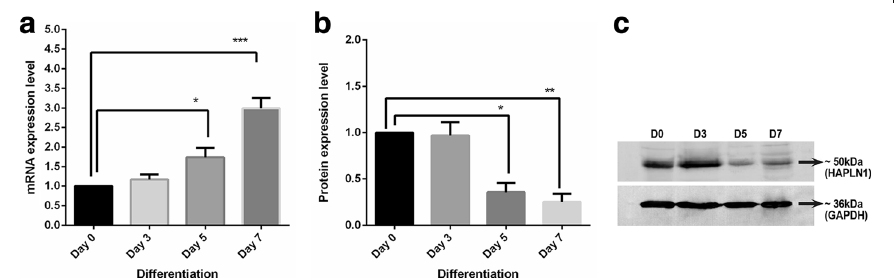
Fig. 2 The expression analysis of HAPLN1 during differentiation at the mRNA level ( a ) and protein level ( b ). Representative western blot analysis of HAPLN1 protein ( c ). mRNA levels were normalized against the PPIA gene. GAPDH was used as a loading control in western blot experiments. * p < 0.05, ** p < 0.01, *** p <